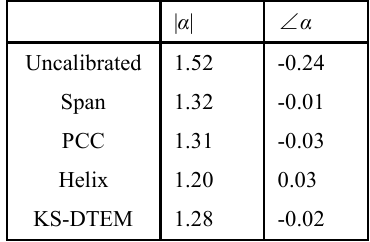
Table 2 . Cross-pol channel imbalance accuracy for different extraction